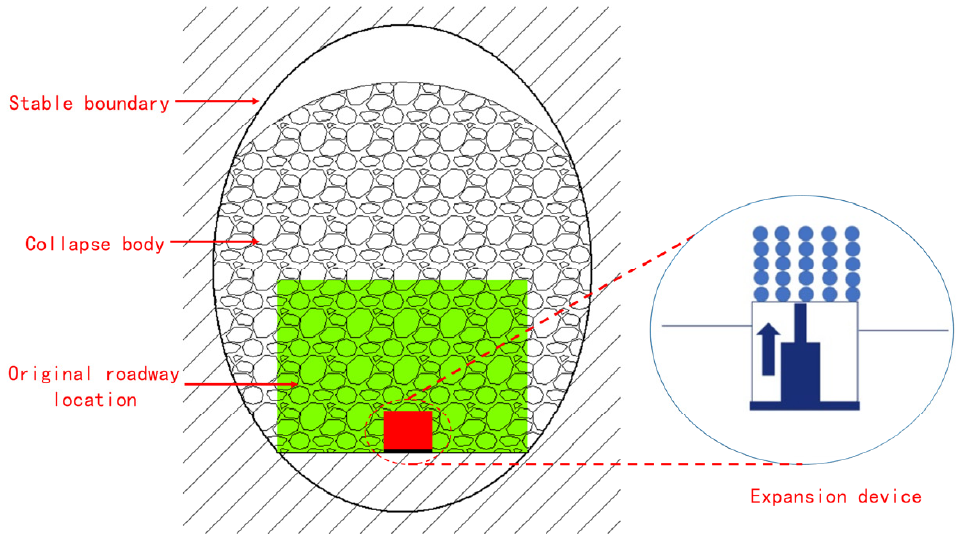
Figure 1. Schematic diagram of rescue channel expansion in collapse body.